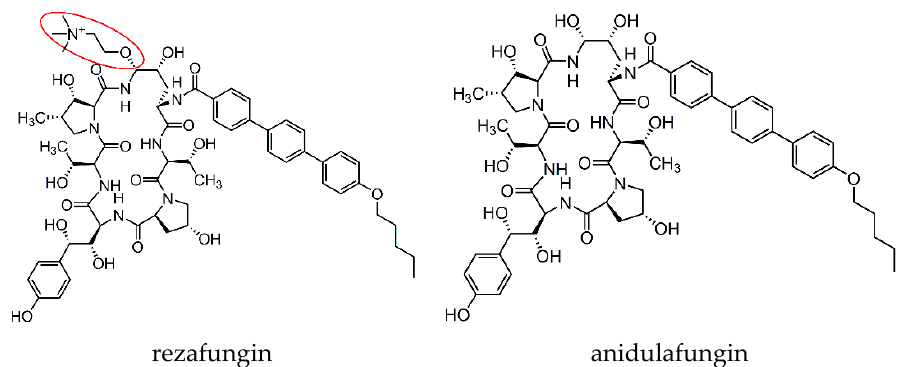
Figure 1. Chemical structure of rezafungin and anidulafungin. The choline amine ether at the C5 ornithine position of rezafungin is circled in red.